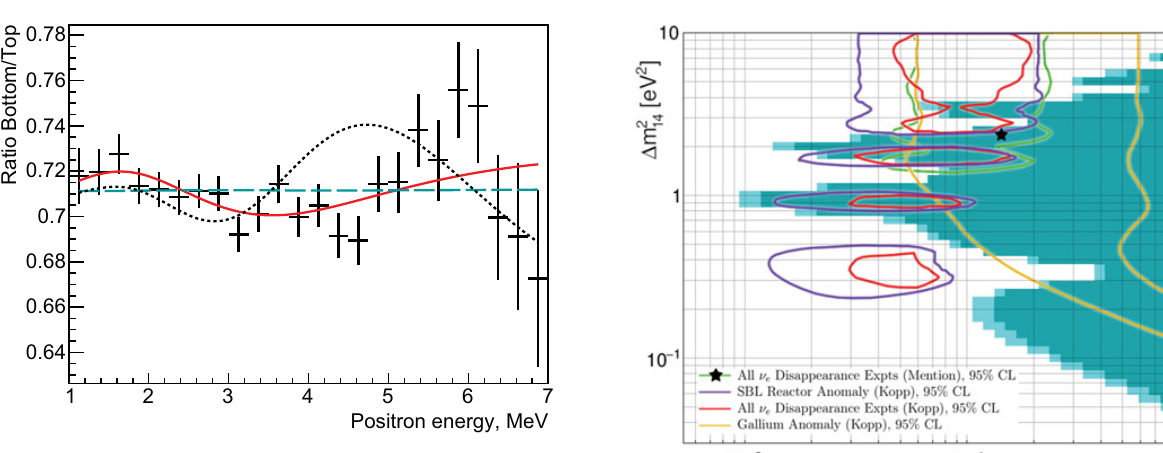
Figure 10. Ratio of positron energy spectra measured at the bottom and top detector positions (statistical errors only). The dashed curve is the prediction for 3 ν case ( χ 2 = 35 . 0, 24 degrees of freedom). The solid curve corresponds to the best fit in the 4 ν mixing scenario ( χ 2 = 21 . 9, sin 2 2 θ 14 = 0 . 05, (cid:2) m 2 The dotted curve is the expectation for the optimum point from the RAA and GA fit [4] ( χ 2 = 83, sin 2 2 θ 14 = 0 . 14, (cid:2) m 2 2 . 3 eV 2 ).